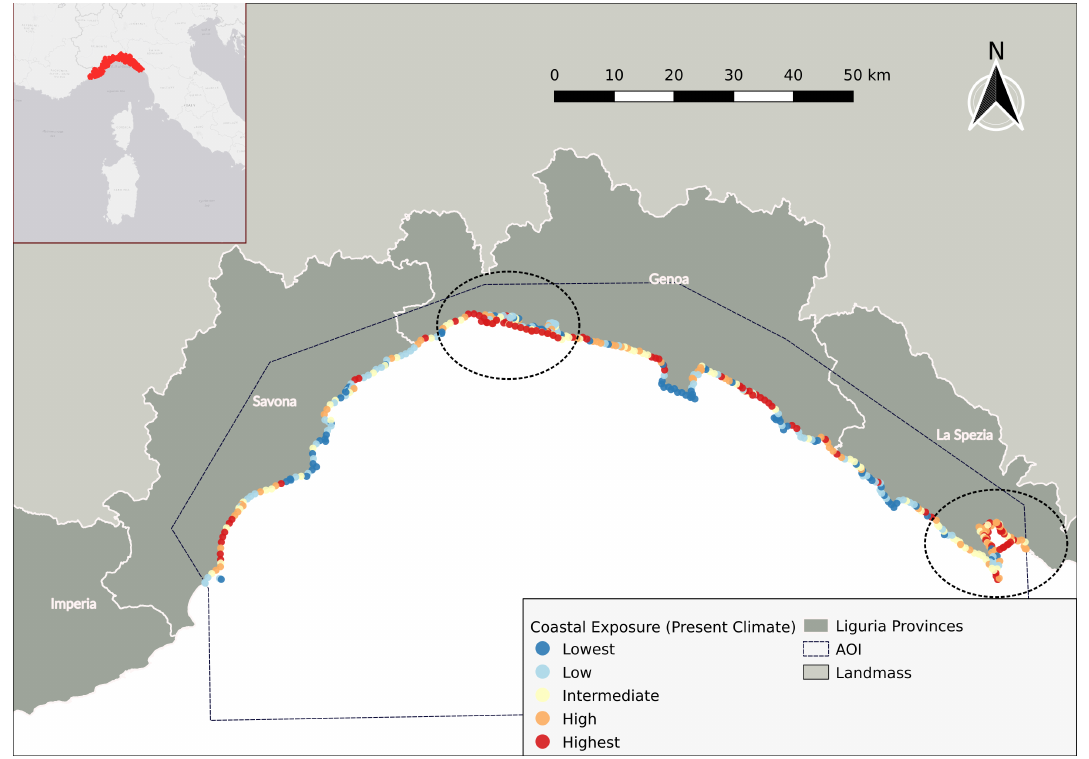
Figure 3. Map of the Exposure Index for the whole area considered in the case study assessment. The Area of Interest (AOI) polygon within which the InVEST Coastal Vulnerability model was run is also highlighted in the map. Liguria’s location within the rest of the landmass is highlighted in red in the upper left corner of the map. Dotted ellipses delineate the location of the two main port areas of the AOI, for which zoomed maps are proposed in Figure